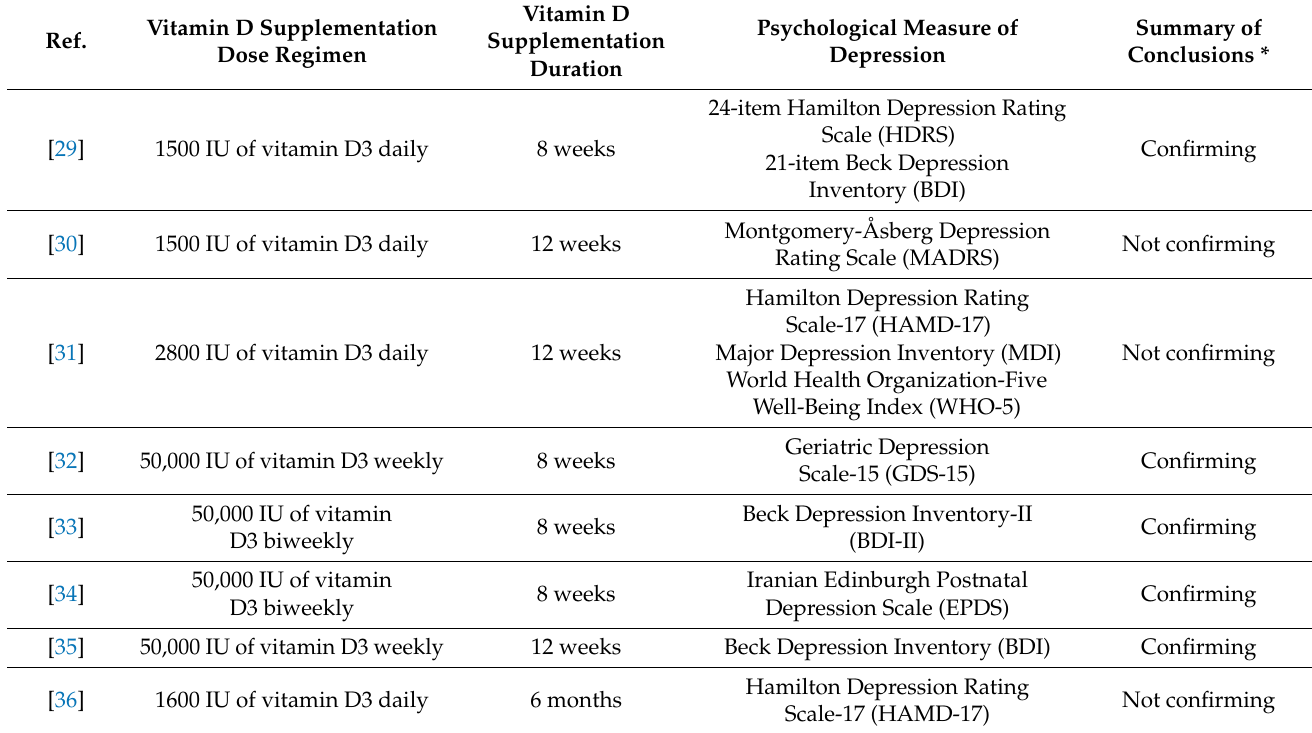
Table 4. The descriptions of the vitamin D supplementation and the assessment of depression status accompanied by the summary of conclusions formulated within studies included to a systematic